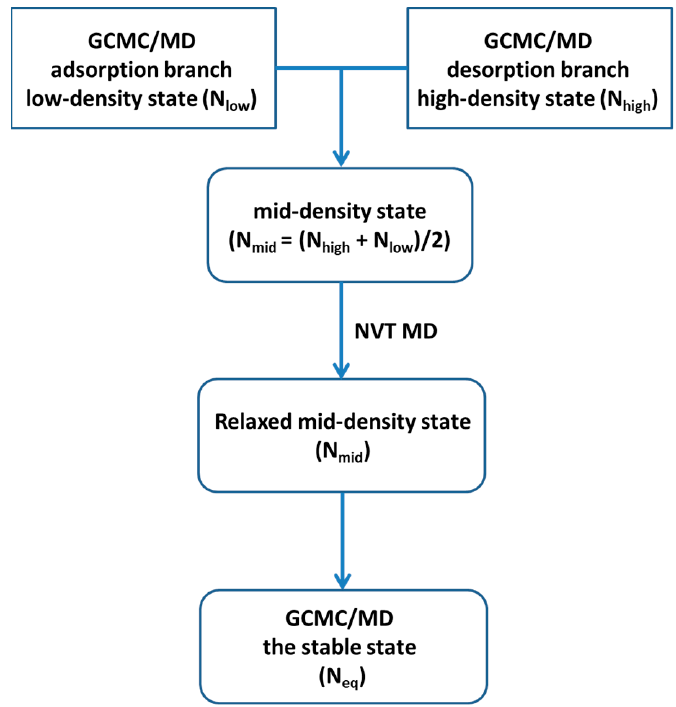
Figure 2. The flowchart of the mid-density scheme applied in this work.